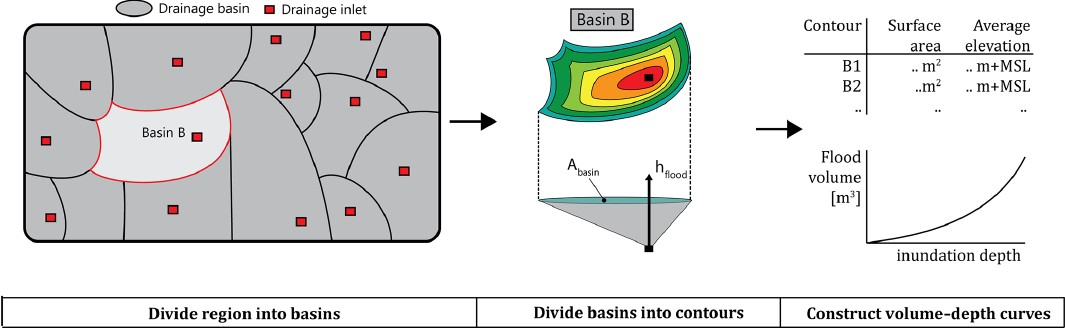
Figure 2. Schematization of the city from GIS data into input data for the FLORES model. Based on the DEM, the region is divided into basins and contours, leading to a volume–depth curve of every basin. This schematization does not include coastal boundaries